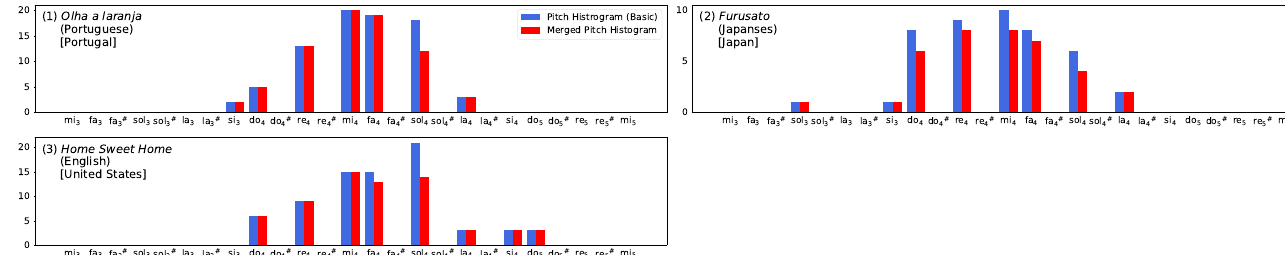
Figure 8. The movable do solfège-based basic and merged pitch histograms for a Portuguese, a Japanese, and an English well-known traditional folk song, respectively, using the Gregorian scale where the basic pitch histograms conform to the bell shape ( DoBell = 1), with the languages of the original version in curved brackets and the countries of the origin in square